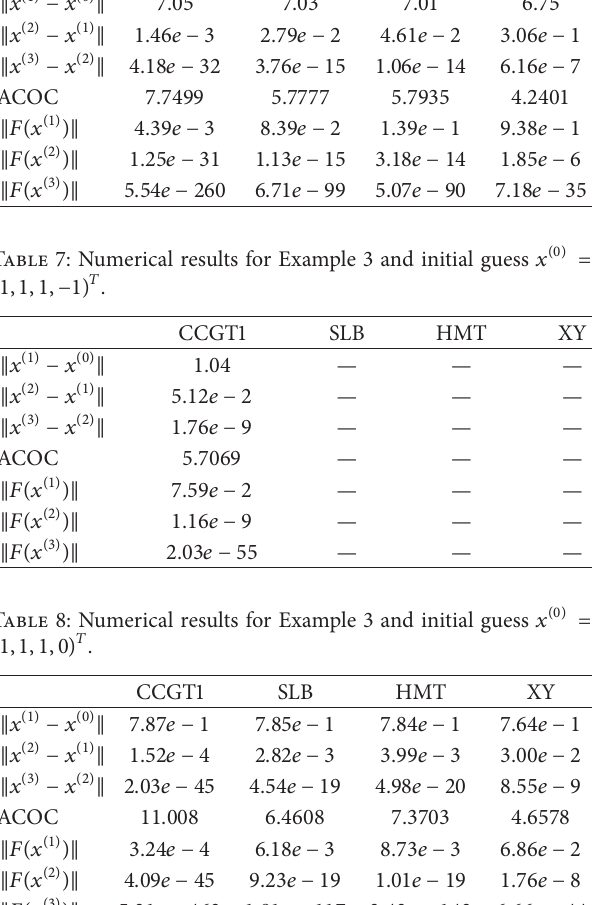
Figure 4: Graphic of the exact error for 𝑡 ∈ [0, 0.1] .